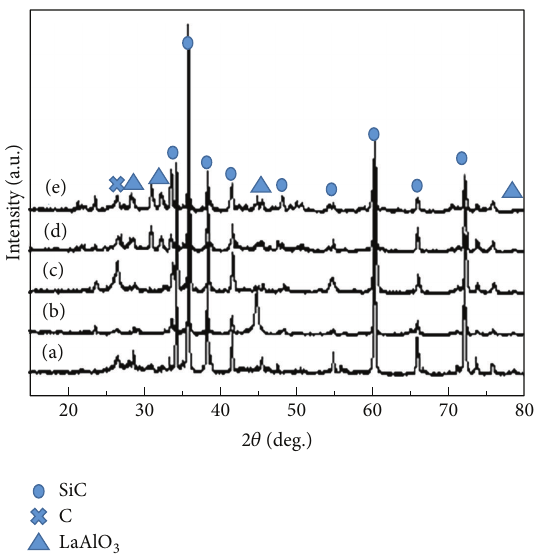
Figure1:X-raypatternsofspecimenswithdifferentannealedtime.(a)representedhotpressedspecimensand(b),(c),(d),and(e)represented annealed specimens AM10, AM30, AM60, and AM90.